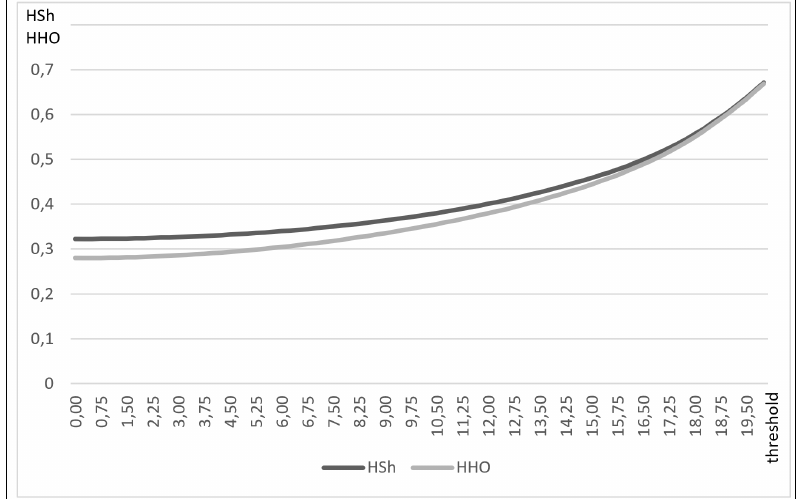
Figure 1: Simulation: Concentration measures Figure 1. Simulation: Concentration